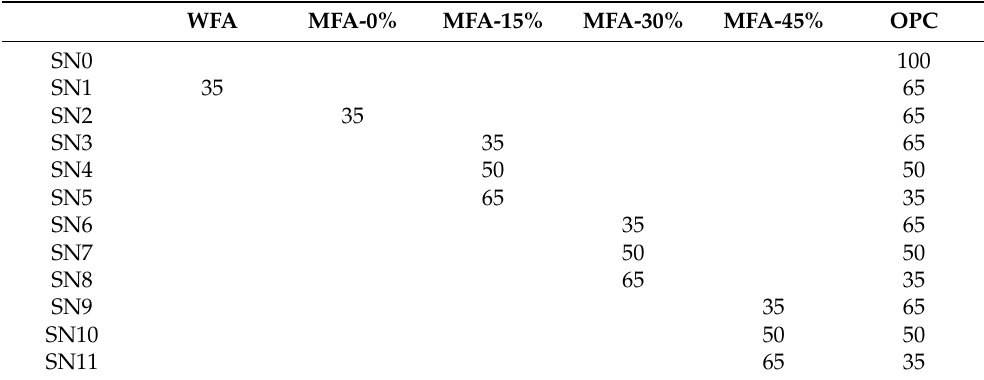
Table 1. Ratio of fly ash used to replace OPC (wt